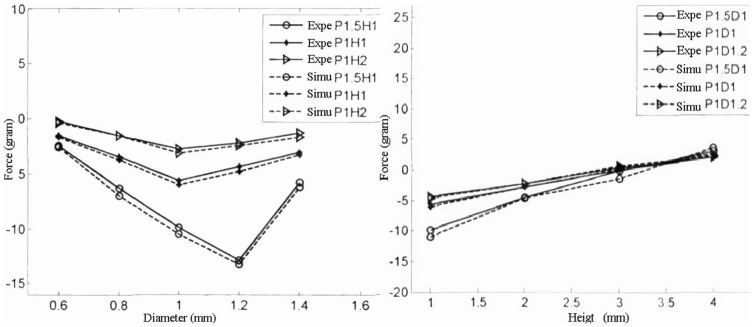
Force applied to finger at different outlet diameters and different contact height.